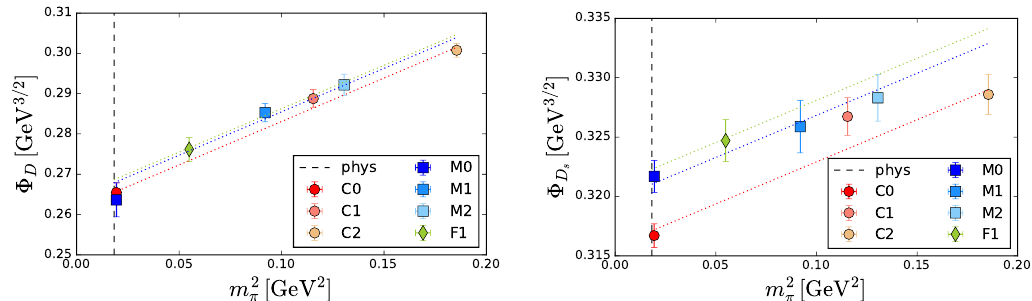
Figure 8 . At the current level of statistical resolution the dependence of (cid:8) D (left) and (cid:8) D on the light valence- and sea-quark masses is well described by a linear (in m 2 representatively show data from all ensembles for the reference point m (cid:17) interpolated linearly in 1 =m (cid:17) . The dashed lines indicate the (cid:12)tted pion mass dependence for the c three lattice spacings.